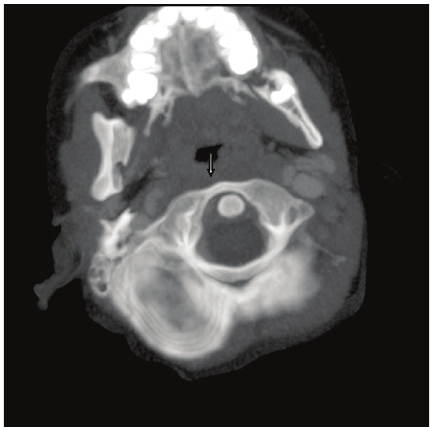
Figure 3: Rotator atlantoaxial subluxation to soft tissue asymmetry